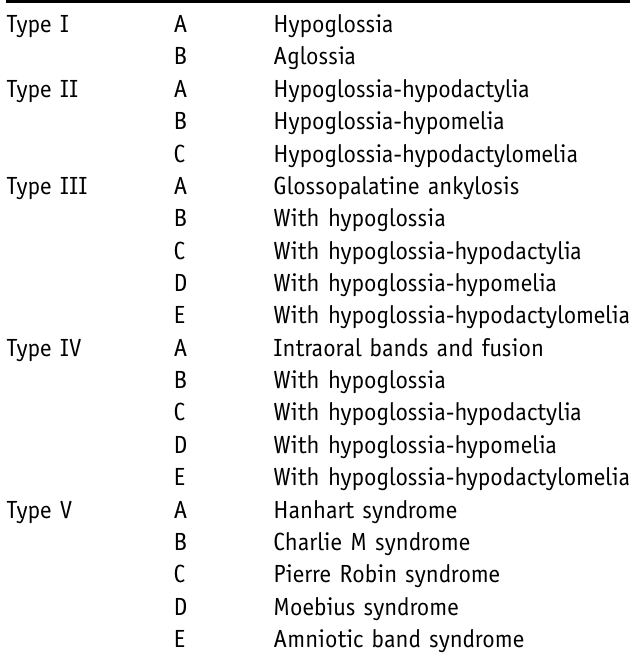
Table I. Hall ’ s classi fi cation of oromandibular limb hypo- genesis syndrome.